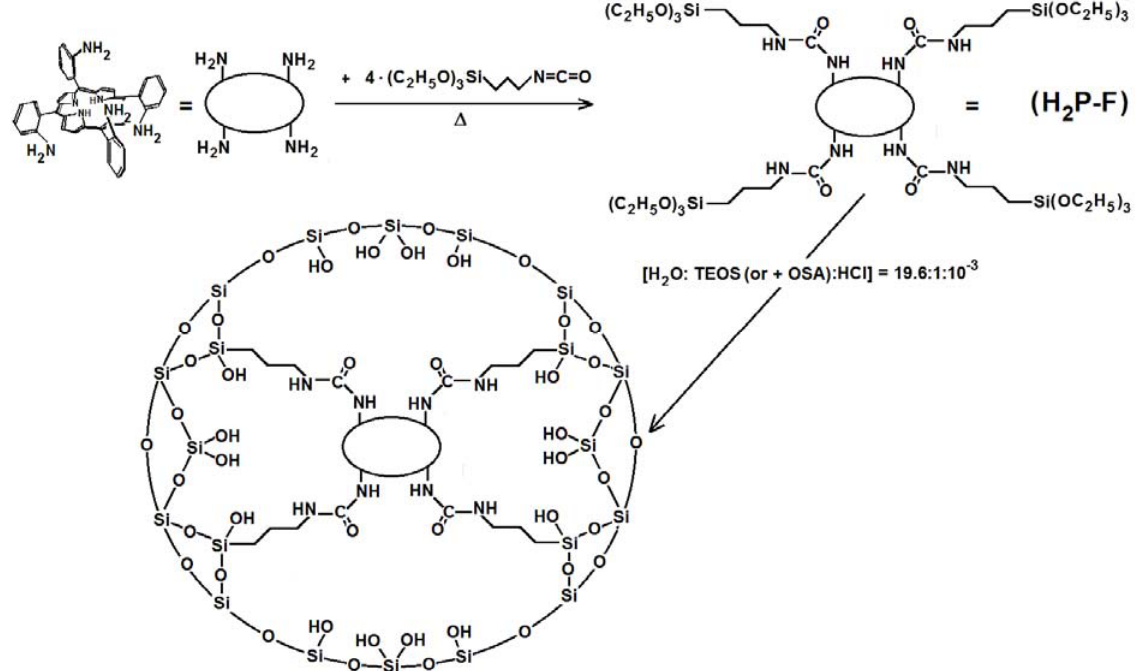
Figure 14. Reaction scheme for bonding of porphyrin free bases, H walls through the use of IPTES to form the respective H entrapping inside the silica pores.